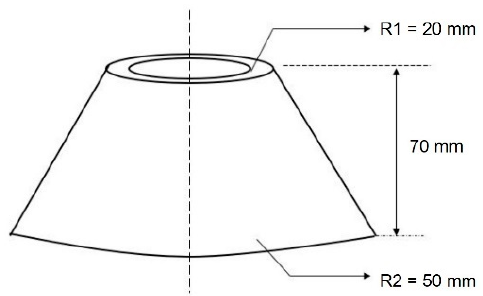
Figure 4. Schematics of the mini slump cone.